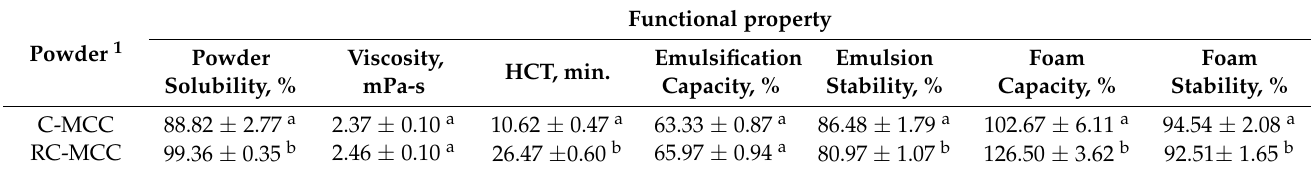
Table 4. Functional characteristics of the micellar casein concentrate (n =